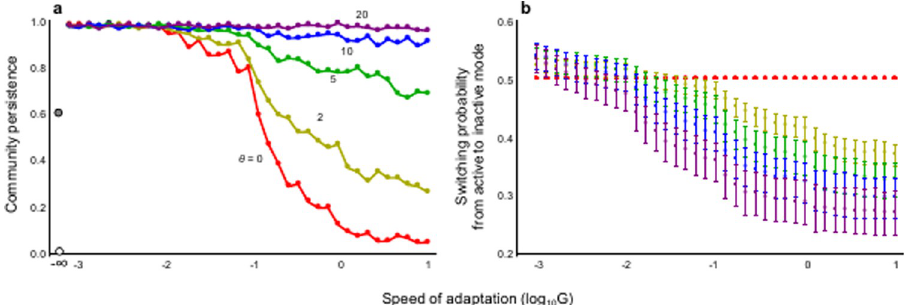
Fig 4. Plastic changes in activity modes and community stability in the case of interaction between the active and inactive modes. (a) Effects of the speed and accuracy of phenotypic switching on community stability; (b) Effects of the speed and accuracy of phenotypic switching on mean switching probability. See S8 Fig for the confidence interval in (a). The white circle in (a) is the result of no adaptation and the gray circle in (a) is the result of a system with only inactive mode. The mean switching probability is calculated as the mean of species mean P in a community after a i sufficiently long time (at an equilibrium) in simulation runs. Each bar in (b) represents the standard deviation. N = 40 and C = 0.3. Parameters are A 12 = 0.01, A 21 = 0.005 and A 22 = 0.001. Other parameters are the same as those in S4